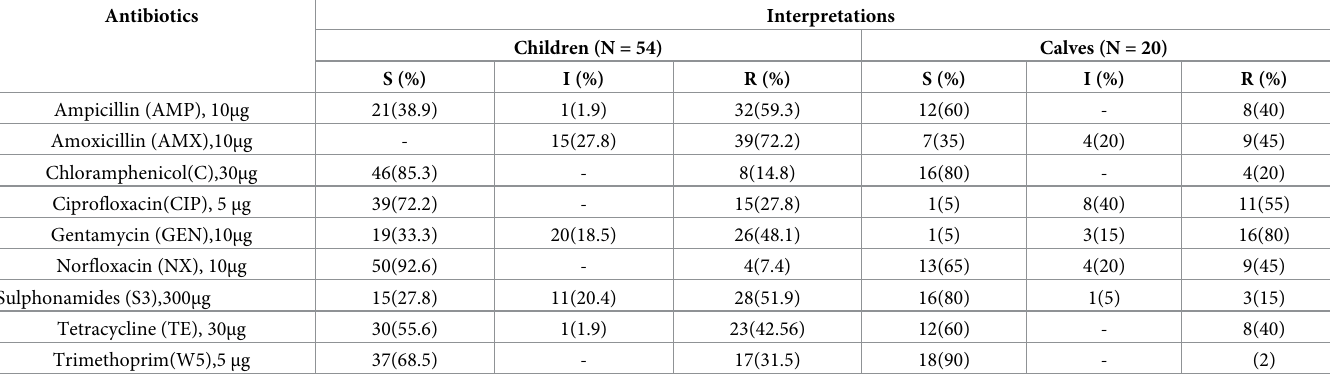
Table 6. Antimicrobial susceptibility profile of Escherichia coli isolates from different sources. Antibiotics